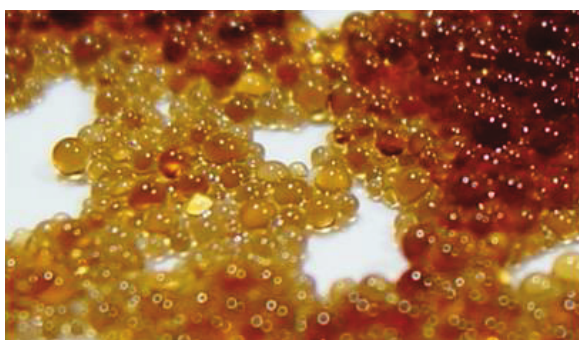
Fig. 1 – Wet particles of the ion exchanger before drying Fig. 1 - Wet particles of the ion exchanger before drying Pavel Hoffman: Effect of fluidized bed stirring on drying process of adhesive particles